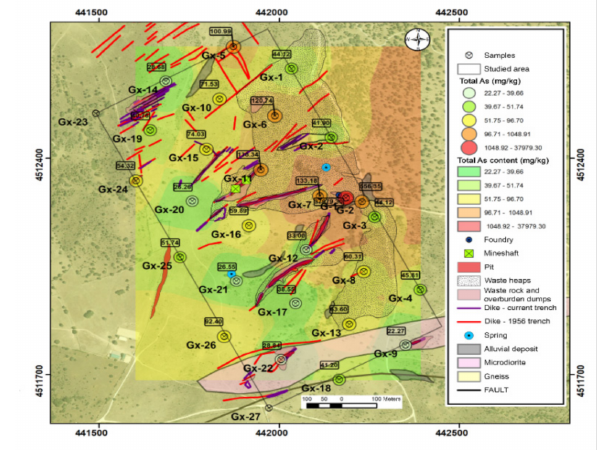
Figure 4. Total arsenic